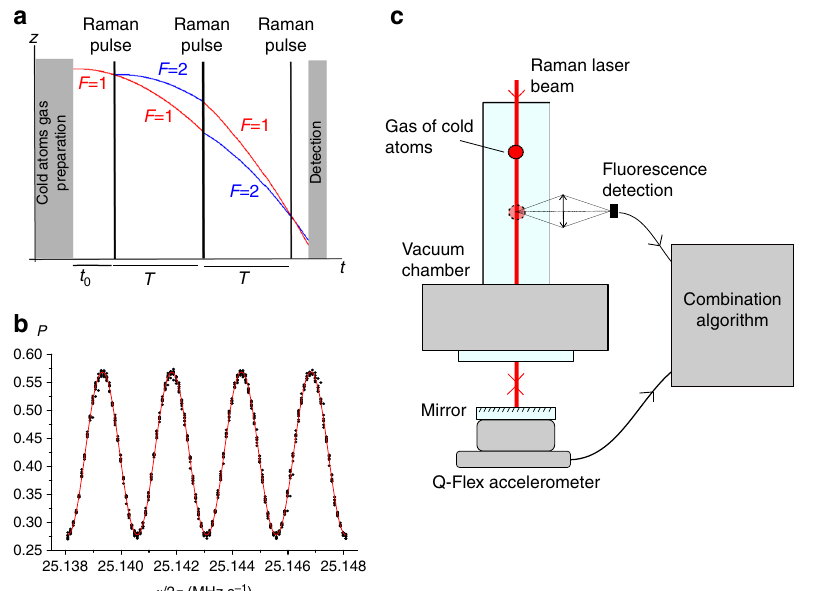
Fig. 2 Principle of the atom accelerometer. a Temporal sequence. b Typical interference fringes acquired in static condition for T = 20 ms. c Setup of the cold atom